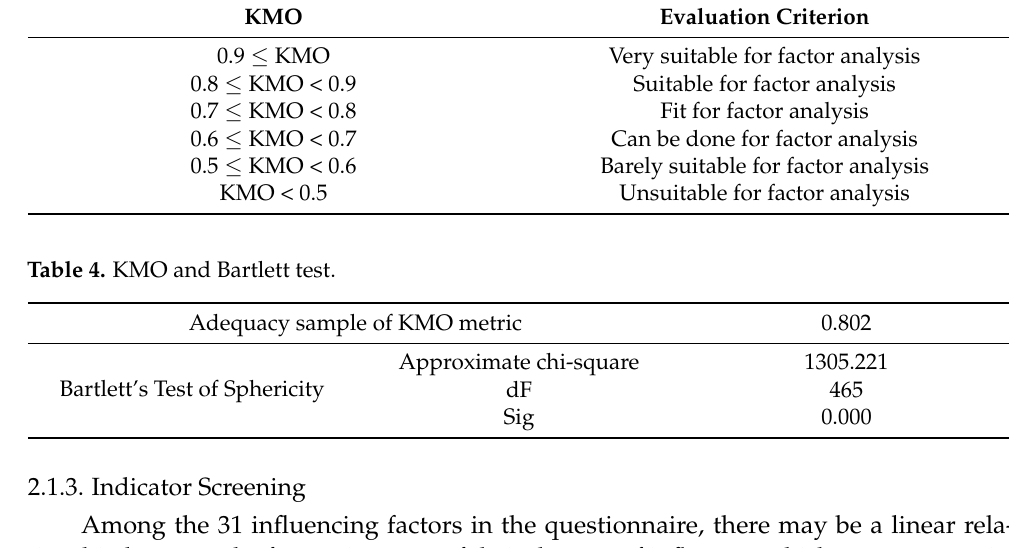
Table 3. KMO inspection criteria.